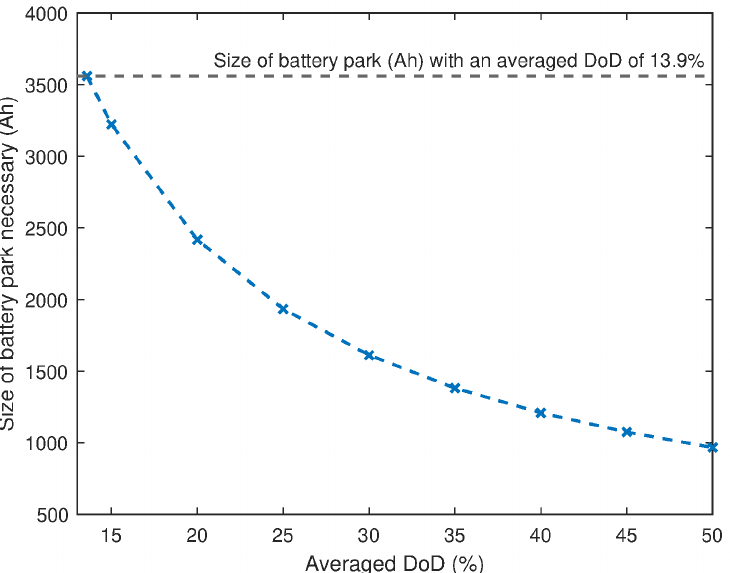
Figure 5. Size reduction of the battery park of Ambohimena with increased Depth of